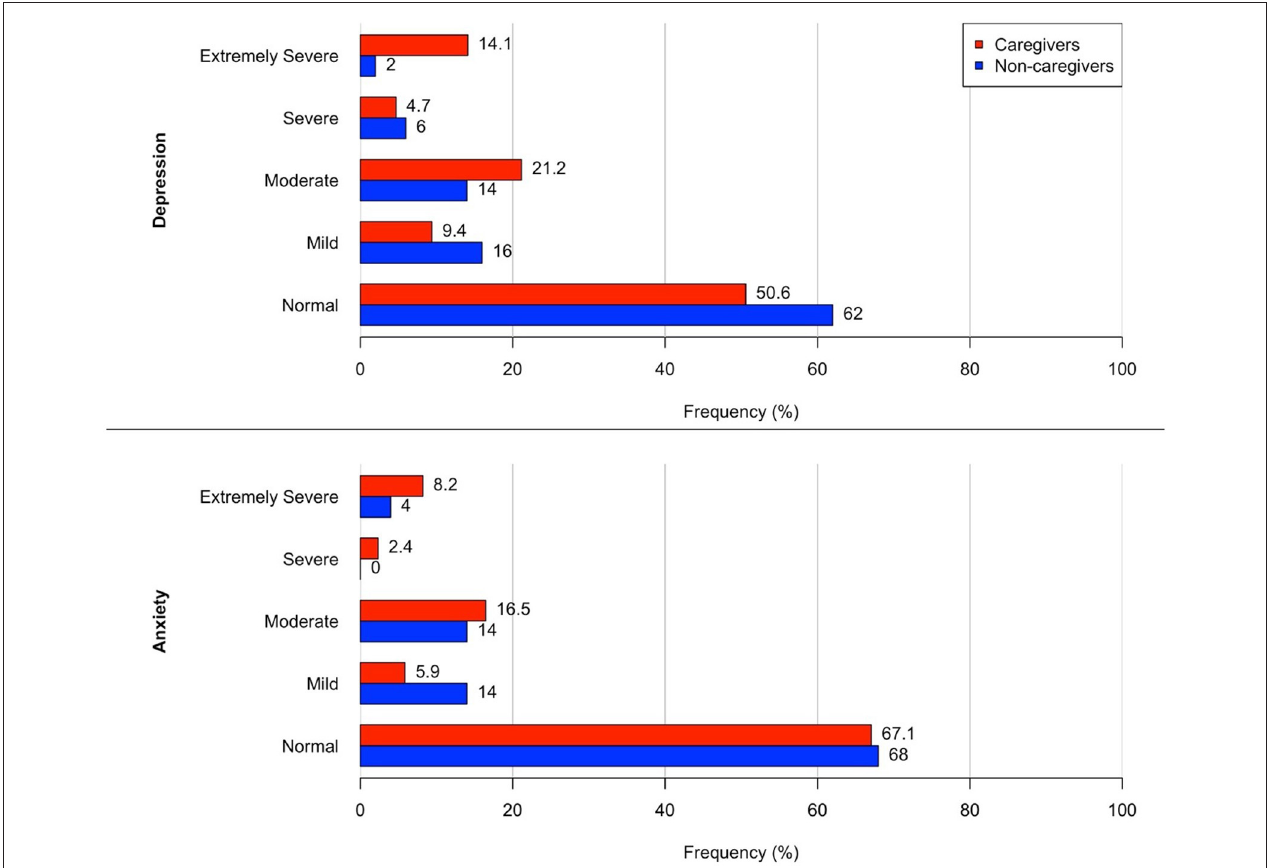
FIGURE 3 | Frequency distribution of DASS-21 Anxiety and Depression levels of severity in caregivers (red) and non-caregivers (blue) 1 year after first restrictions (T2, March-April 2021), Recommended cut-off scores for severity levels were considered as following: depression = normal 0–9, mild 10–13, moderate 14–20, severe >